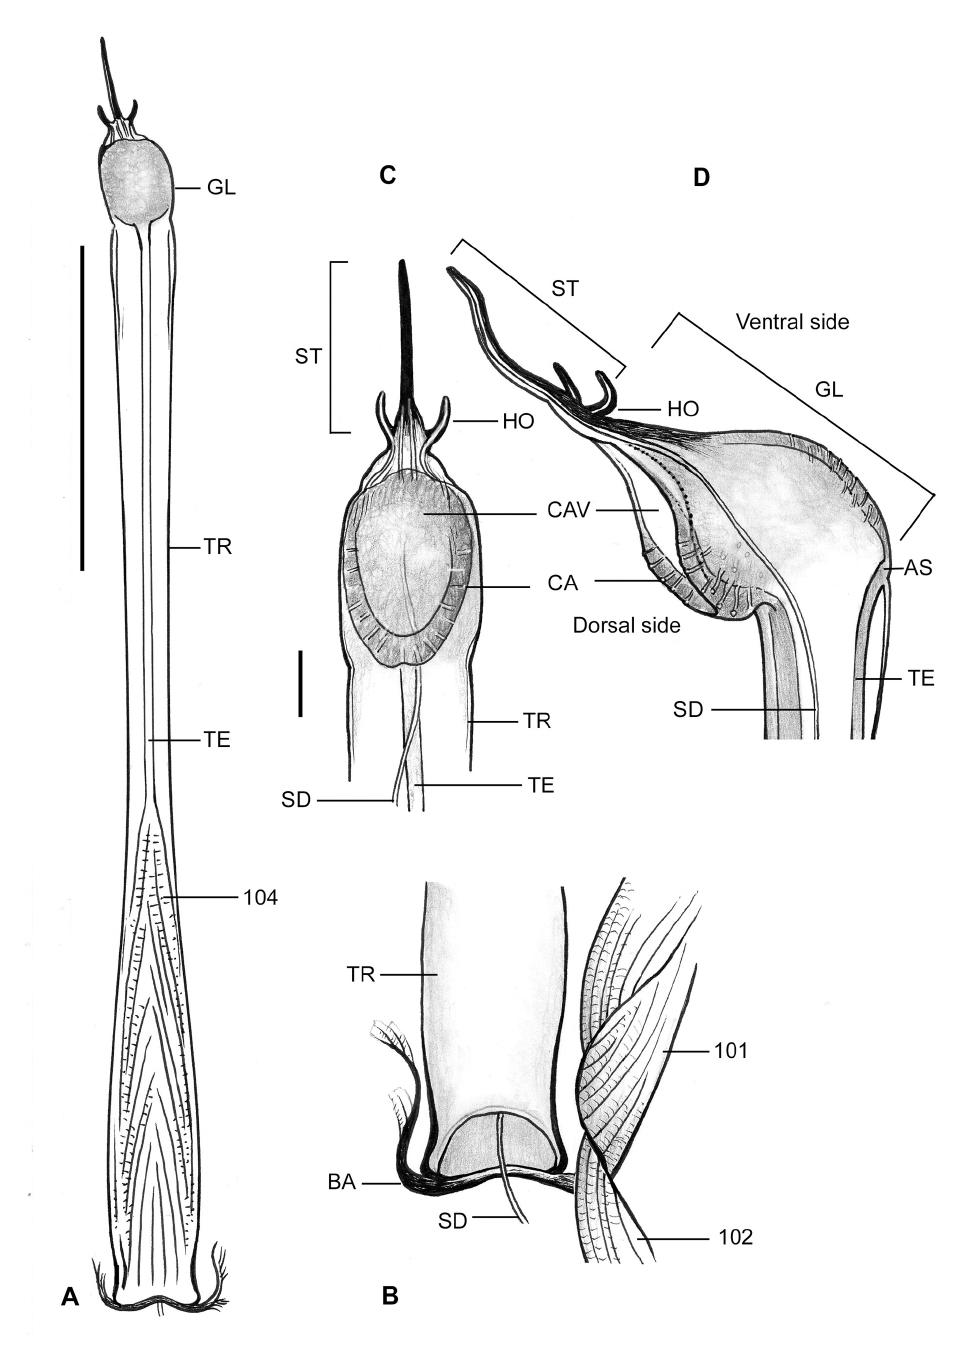
Fig. 3. Dicranopalpus gallaecicus sp. nov., penis morphology, schematised (CHW 492). A . Ventral view. B . Dorsal view of proximal truncus, left side with basal extension, muscles torn off during preparation, right side with basal extension including attached extrinsic penial muscles. C . Dorsal view of glans. D . Dorsolateral view of glans. Abbreviations: AS = distal attachment site of intrinsic penial muscle; BA = basal extension; CA = canaliculus; CAV = glans cavity; GL = glans; HO = horns; SD = seminal duct; ST = stylus; TE = tendon of intrinsic penial muscle; TR = truncus; 101 = anterior extrinsic penial muscle; 102 = posterior extrinsic penial muscle; 104 = intrinsic penial muscle. Scale bars: A = 0.5 mm; B–D = 50